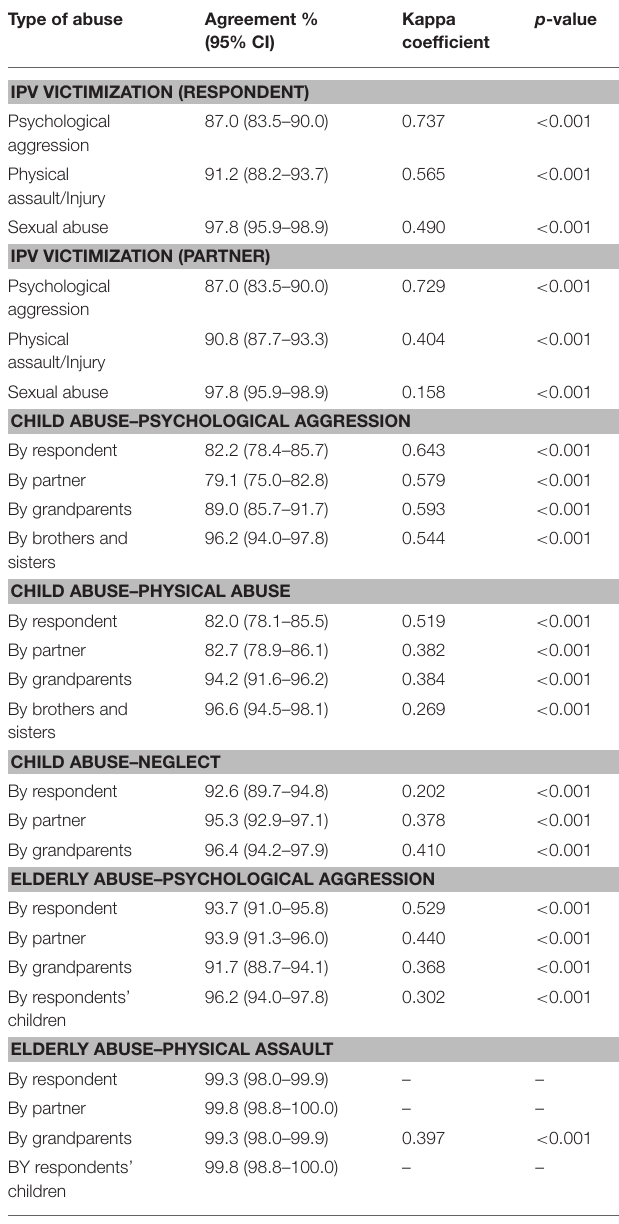
TABLE 1 | Agreement between the family polyvictimization scale and the criterion standards ( N =